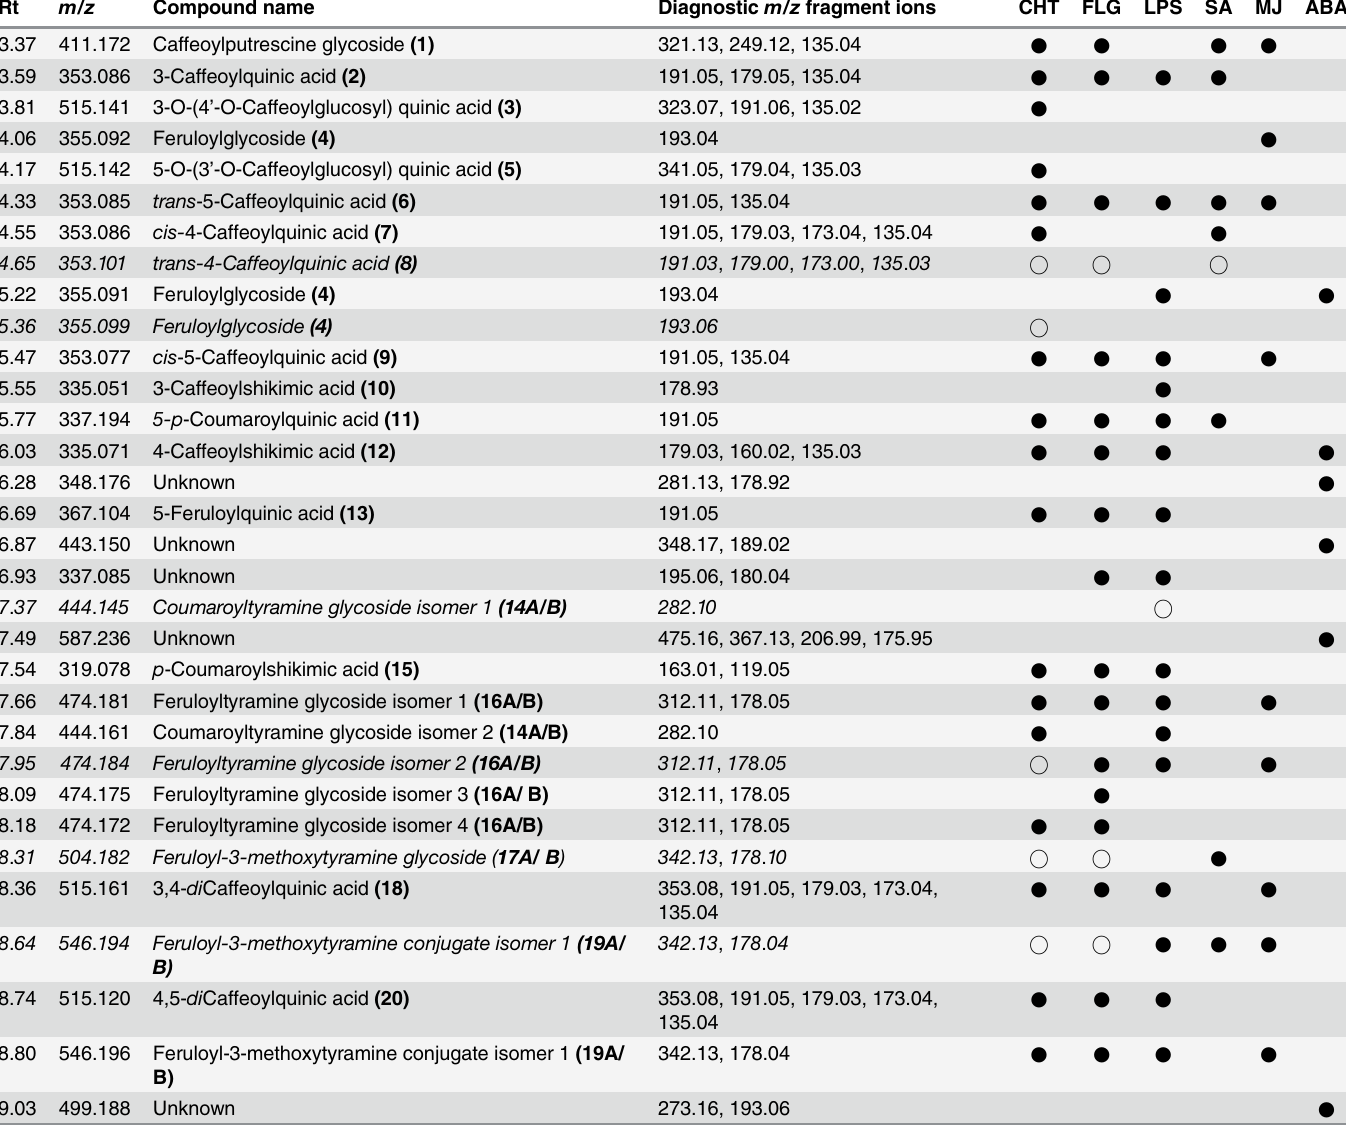
Table 1. UHPLC-MS diagnostic ions (ESI-negative mode) used for the identification of biomarkers in LPS, CHT and FLG-treated tobacco cells. The common and unique biomarkers in response to MAMP elicitation are shown and compared to the phytohormones salicylic acid (SA), methyljasmonate (MJ) and absiscic acid (ABA). Biomarkers derived from both SIMCA and XC-MS analyses are listed. Annotated metabolites that were negatively correlated with the various treatments are indicated in italics and open circles.